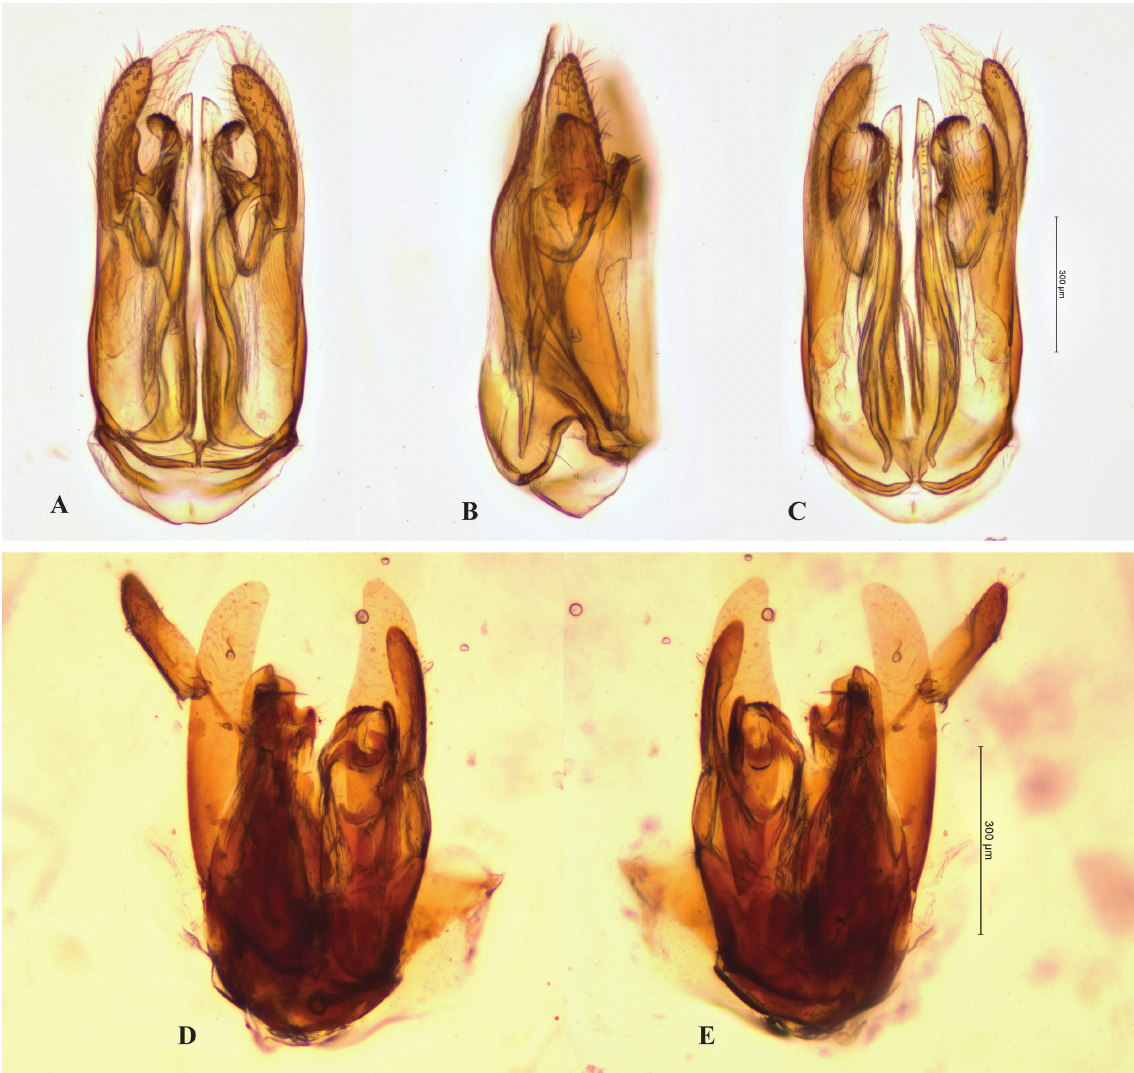
Fig. 4. Genitalia. — A–C . Bradepyris jordanicus sp. nov. A . Ventral view. B . Lateral view. C . Dorsal view. — D–E . Bradepyris baleariensis sp. nov. D . Ventral view. E . Dorsal